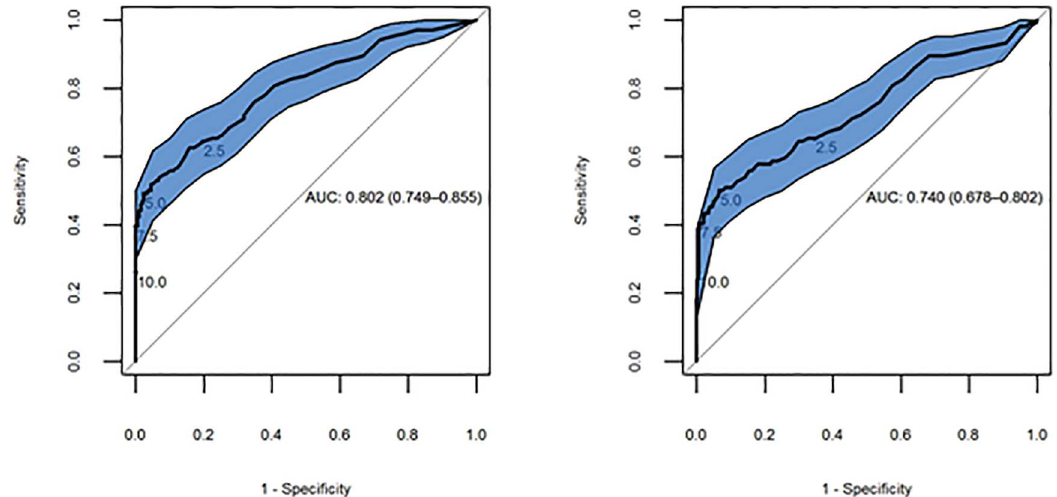
Fig 2. ROC curves depicting the accuracyof the final CEA value (left) and any rise above threshold (right). The sensitivitiesand specificitiesachievedat thresholds of 2.5, 5, 7.5 and 10 μ g/Lare highlighted.